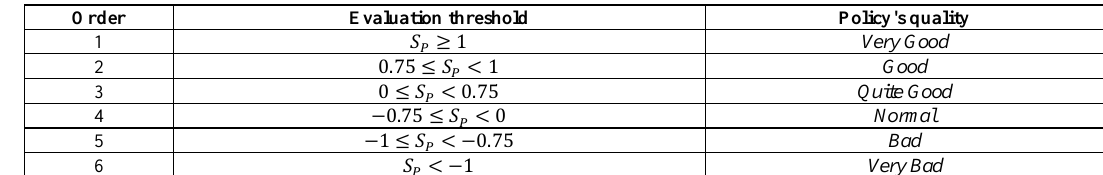
Table 14. The evaluation threshold for the policy’s